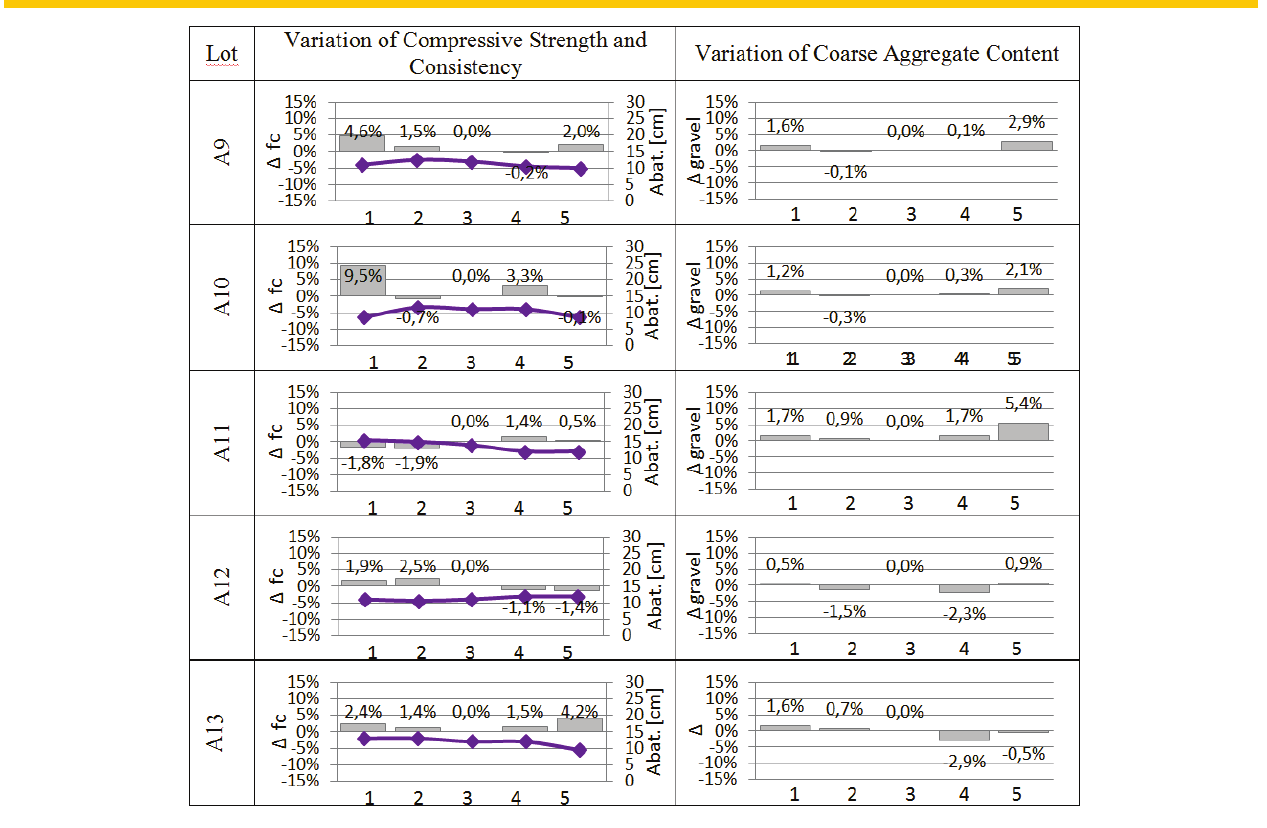
Figure 4 – Profile of variations in compressive strength, consistency and coarse aggregate content - lots 9 to 13